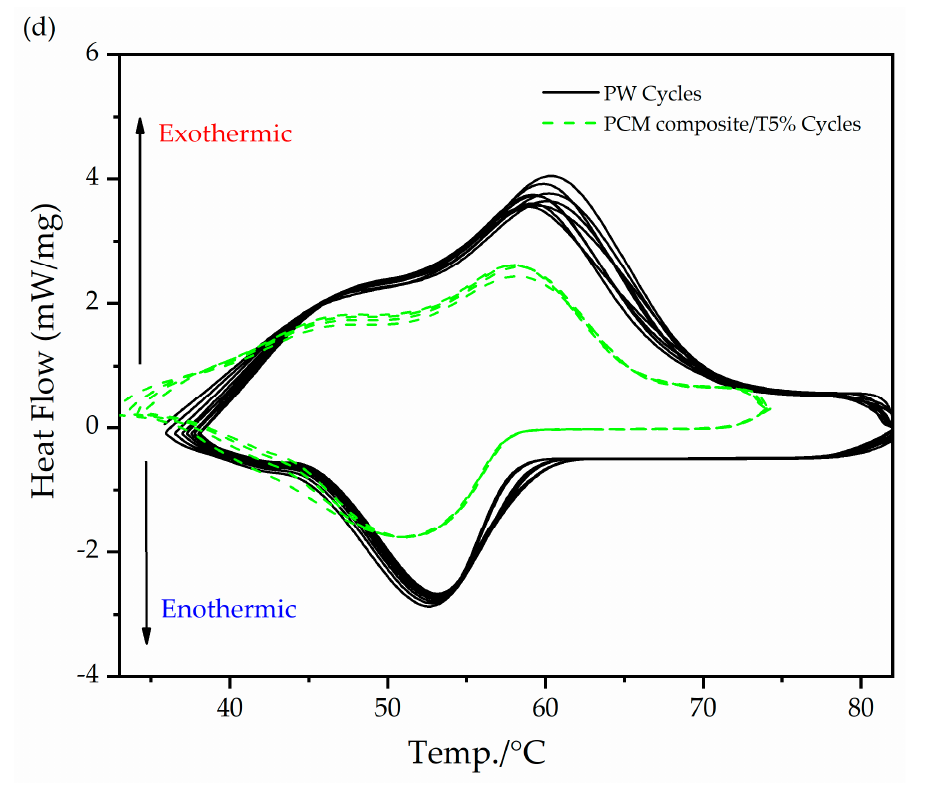
Figure 5. ( a ) DSC thermograms and cycle of a PCM composite 3%. ( b ) PCM composite 5% and cycle. ( c ) PCM composite 7% and cycle. ( d ) Comparing composite 5wt.% with paraffin after different cycles.